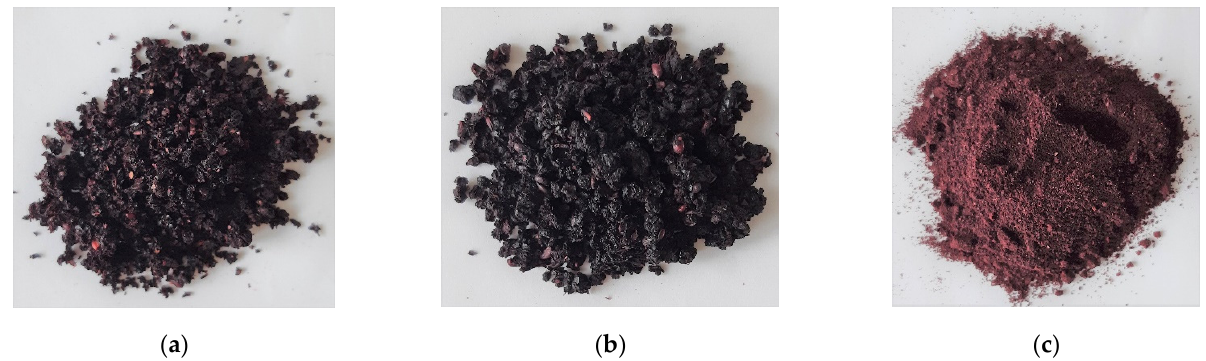
Figure 3. Chokeberry fruits crushed to a powder form, dried using the CD ( convection drying ) method to a w : ( a ) 0.4, ( b ) 0.3, and ( c ) 0.2.